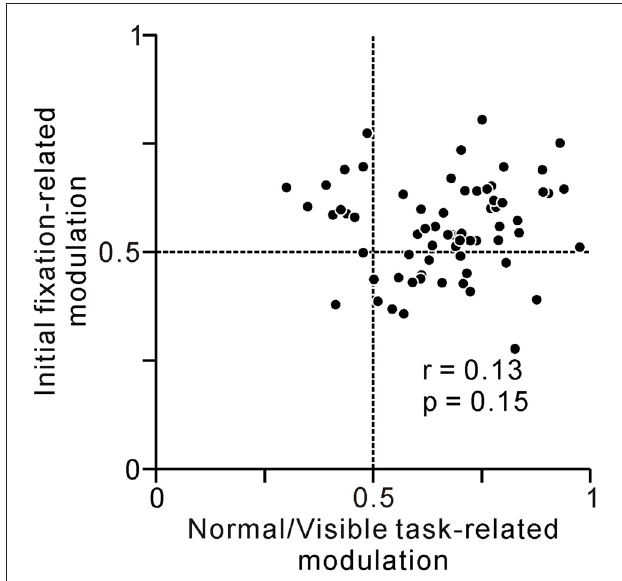
FIGURE 7 | A plot of normal/visible task-related modulation ( x -axis) vs. initial fixation-related modulation ( y -axis) . Task-related activity modulation at the last phase of the saccade task was measured by comparing average firing rates at the reward period between normal vs. visible trials using ROC analysis. Behavior-related modulation at the initial phase of the task was measured by comparing average firing rates at 0–600 ms before the appearance of the initial FT between short vs. long reaction times to FT trials using ROC analysis.